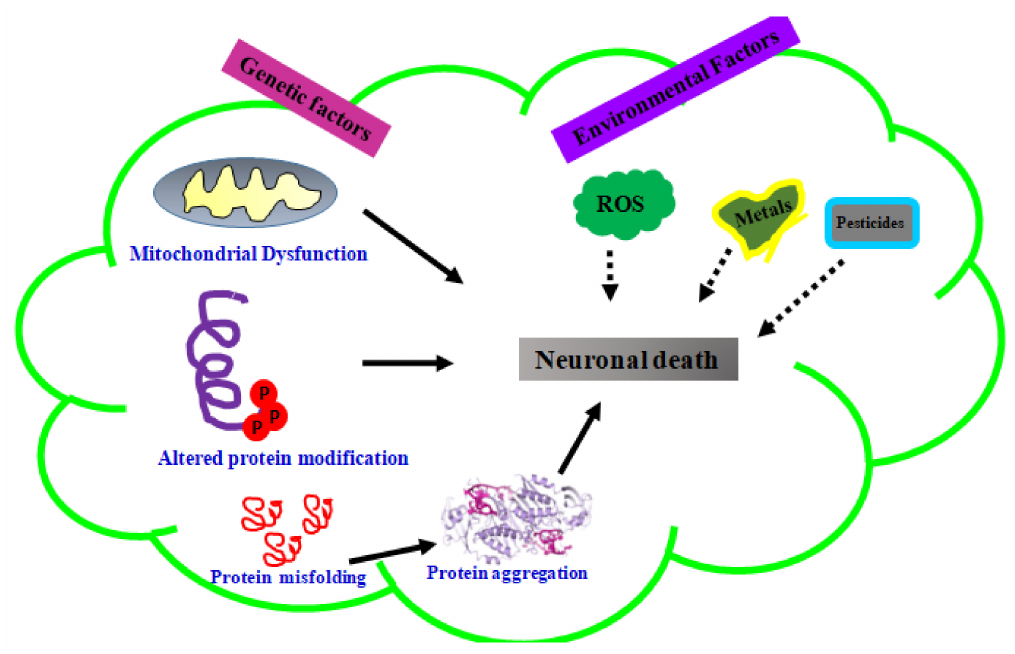
Figure 1. Various factors involved in progression of neurodegenerative